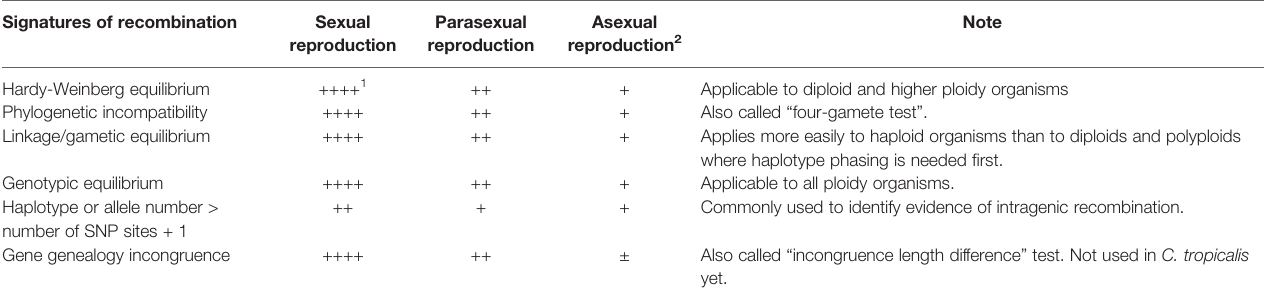
TABLE 1 | Population genetic expectations of different modes of